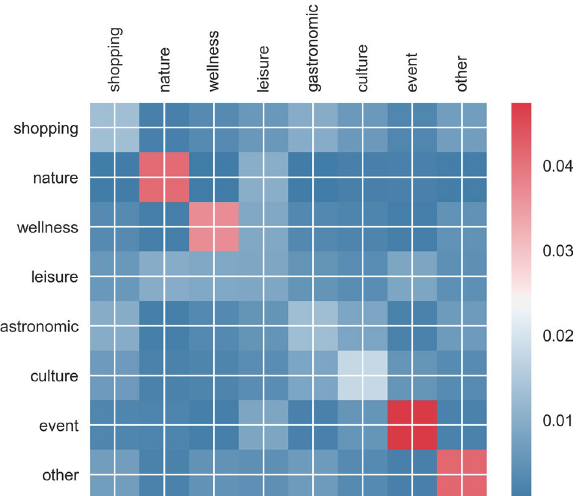
Figure 5. Normalized transition probabilities from one to another type of POIs. The x-axis and y-axis correspond to the type of POI of the first and the second encounter. From blue to red correspond to infrequent to frequent pairs of POIs.